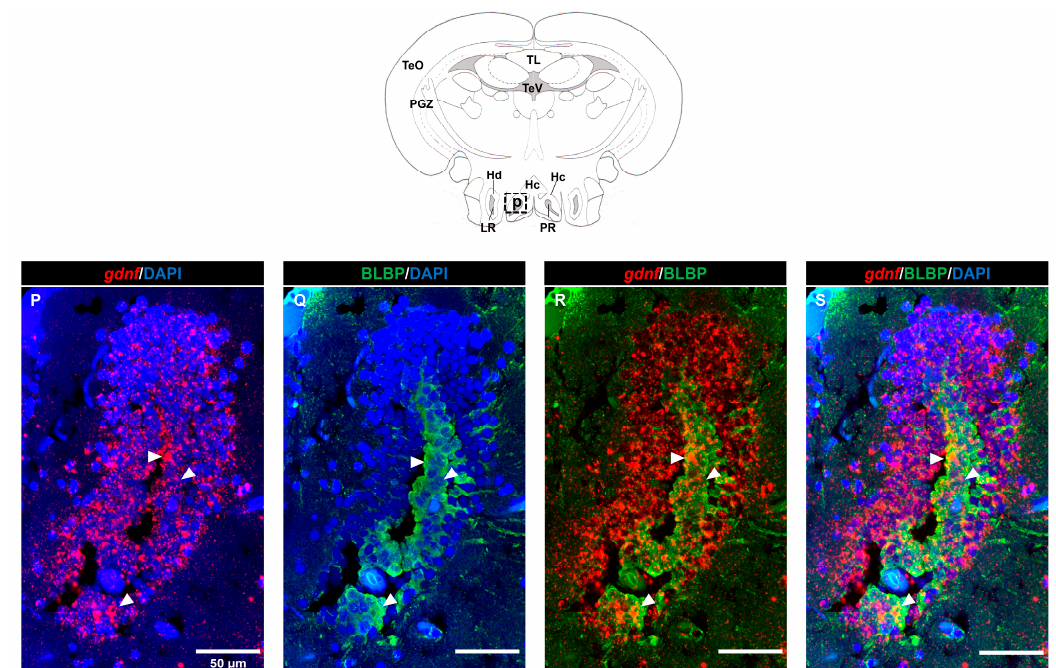
Figure 2. Co-expression of gdnf and radial glial cell markers using FISH / immunohistochemistry. ( A – C ) gdnf is expressed with glial fibrillary acidic protein (GFAP) and ( D – G ) brain lipid-binding protein (BLBP) along the ventral telencephalic area, as indicated by the white arrowheads, ( H ) but only few cells with BLBP in the lateral margin of the periventricular gray zone (PGZ) of the optic tectum in the mesencephalon. Enlarged regions of PGZ with di ff erent layers of selected z-stacks that consist of BLBP-positive cells in the ( I – K ) outer layer and ( L – N ) inner layer and that are depicted in the ( O ) schematic diagram. ( P – S ) gdnf mRNA-positive cells are also BLBP immunoreactive in the caudal zone of periventricular hypothalamus (Hc) (the images were constructed from the selected z-stacks). Black dashes in the graphical illustrations outline the regions of interest. The white dashes outline the regions of higher magnification that were constructed from the selected